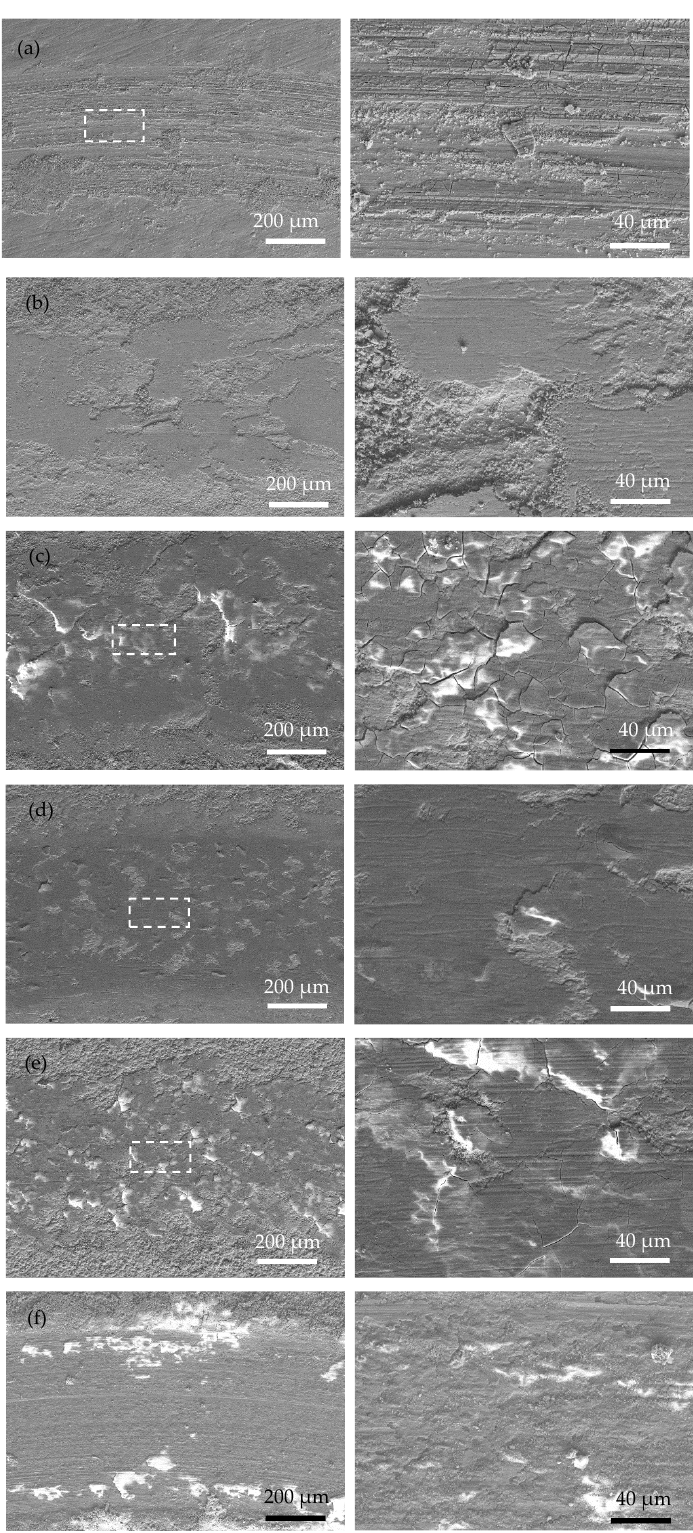
Figure 6. Surface morphology of the wear scar of the as-plated coatings at low magnification (left) and high magnification (right), the dotted frame means the scanning area of Table 3: ( a ) Ni-P; ( b ) Ni-P-Si 3 N 4 ; ( c ) Ni-P-Si 3 N 4 -WS 2 , 0.5 g/L; ( d ) Ni-P-Si 3 N 4 -WS 2 , 1.5 g/L; ( e ) Ni-P-Si 3 N 4 -WS 2 , 2.5 g/L; ( f ) Ni-P-WS 2.